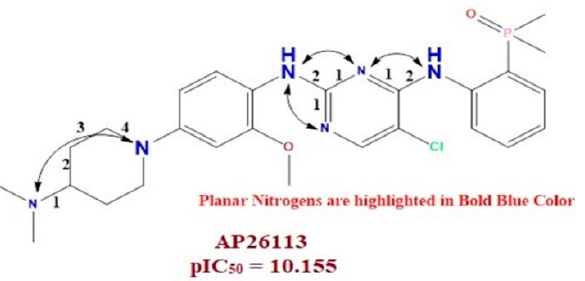
Figure 4. Illustration of Molecular descriptor N_plaN_4B in clinical trial molecule AP26113 (IC 50 = 0.07 nM).